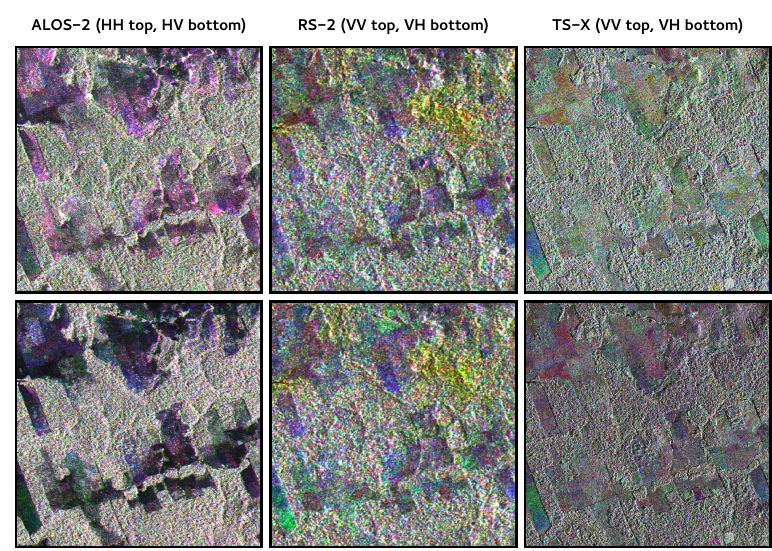
Figure 2. Composites of the available SAR images consisting of January (red), March (green), and June (blue)